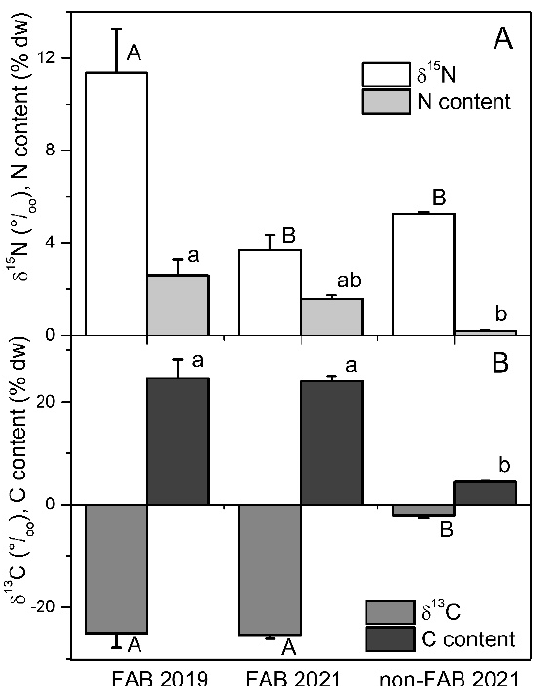
Figure 3. δ 15 N signature and N content ( A ) and δ 13 C signature and C content (( B ), n = 4) of filamen- tous algae blooms (FAB) at the western shore and non-FAB at the eastern shore of Bear Lake in October 2019 and June 2021 (+standard error). Different letters indicate significant differences among FAB 2019, FAB 2021 and non-FAB 2021 values (one way ANOVA, p < 0.05, Tukey’s post hoc test).